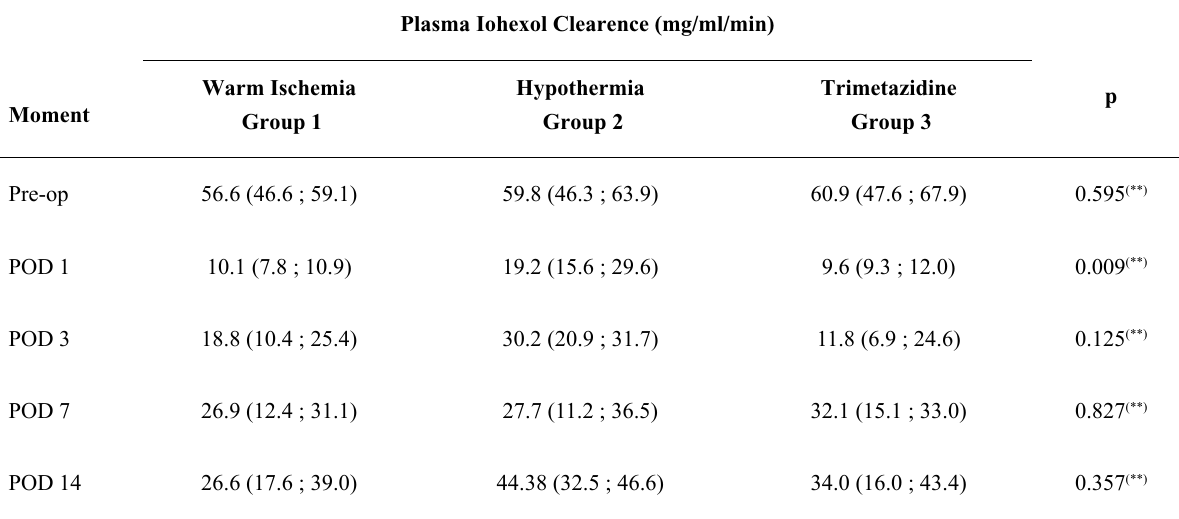
Table 3 - Plasma iohexol clearance values at baseline and PODs 1, 3, 7 and 14 in each